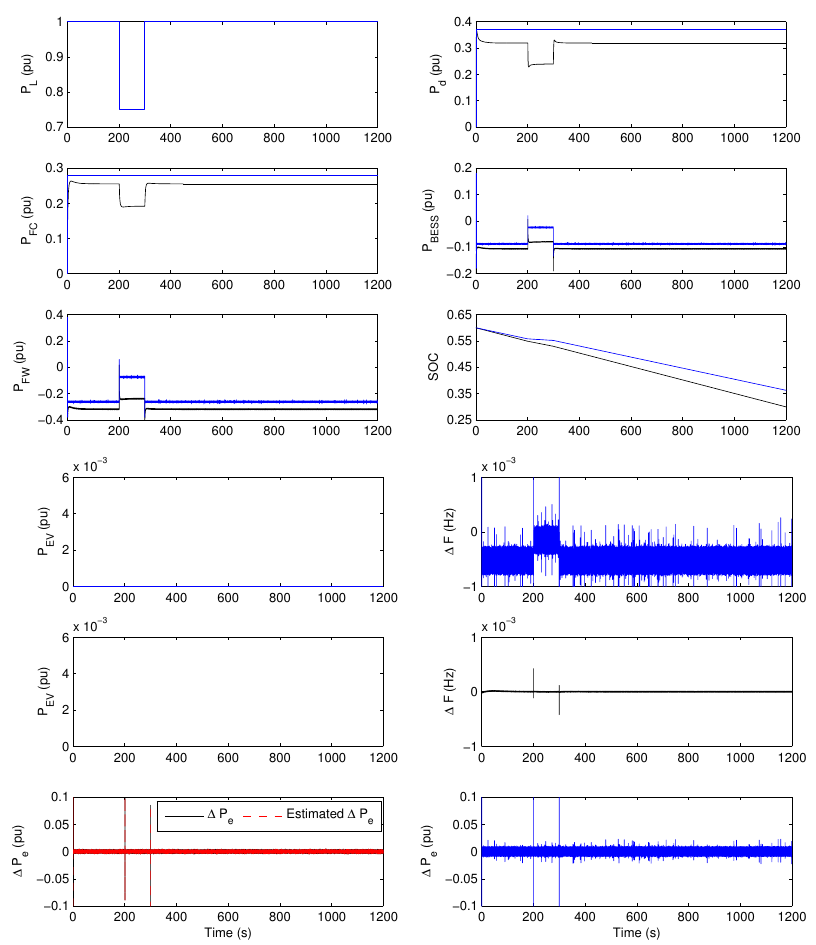
Figure 11. Case 4 simulation results: proposed (black) and conventional